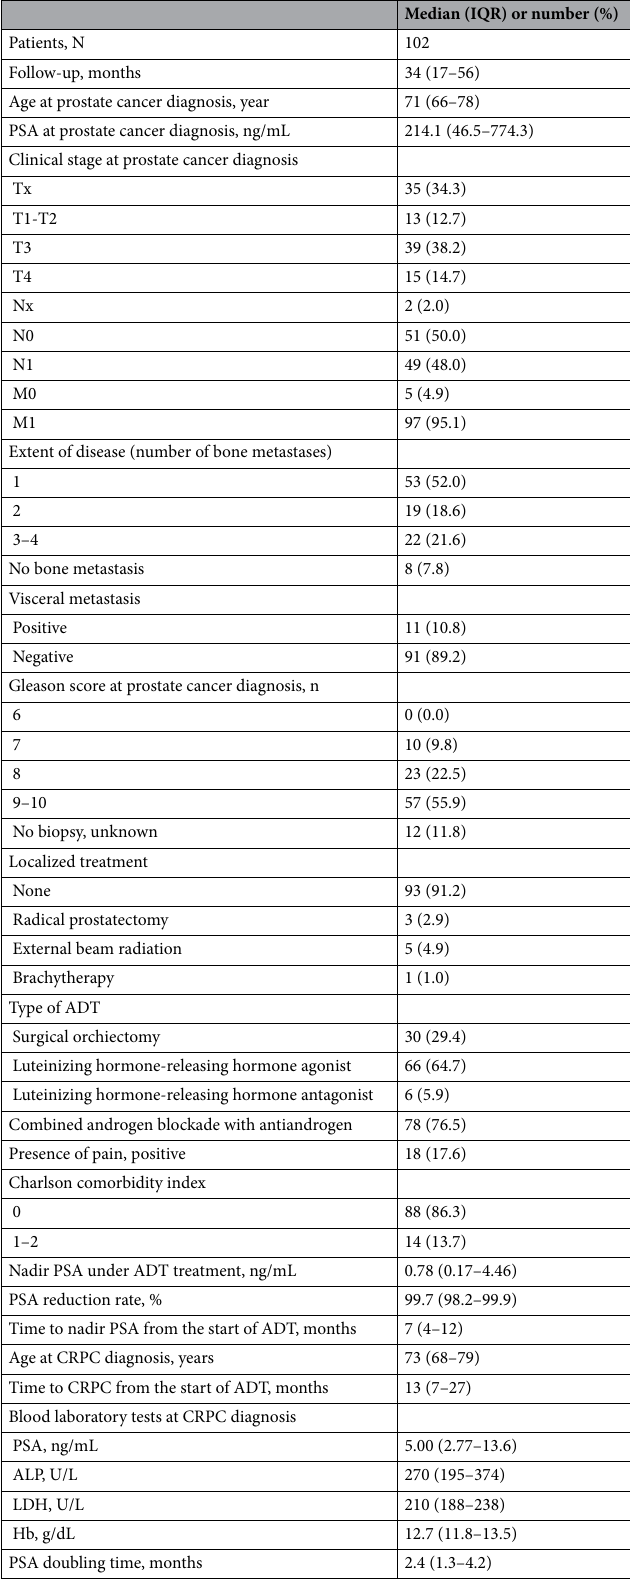
Table 1. Clinical and histological characteristics of M1CRPC patients. IQR Interquartile range, PSA prostate- specific antigen, ADT androgen deprivation therapy, CRPC castration-resistant prostate cancer, ALP alkaline phosphatase, LDH Lactate dehydrogenase, Hb